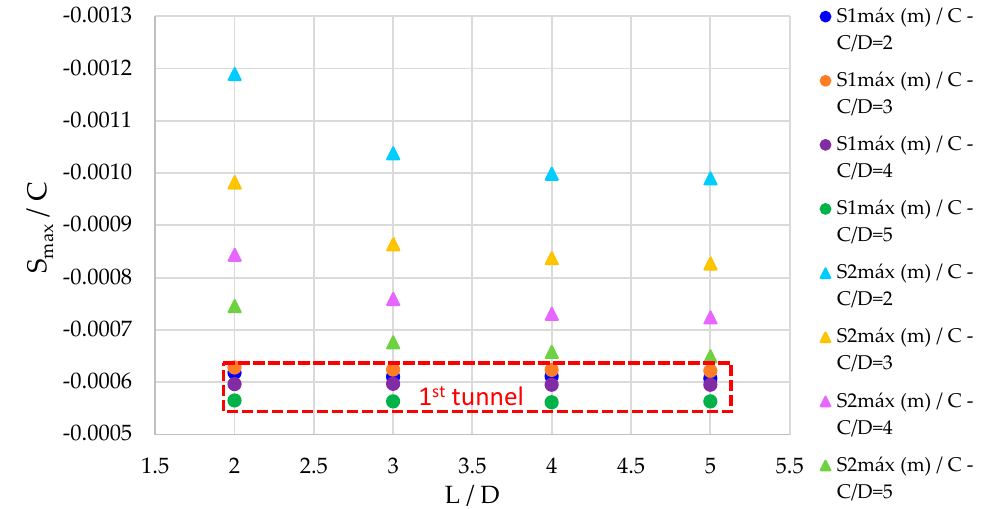
Figure 6. Geometry influence on the maximum settlement.